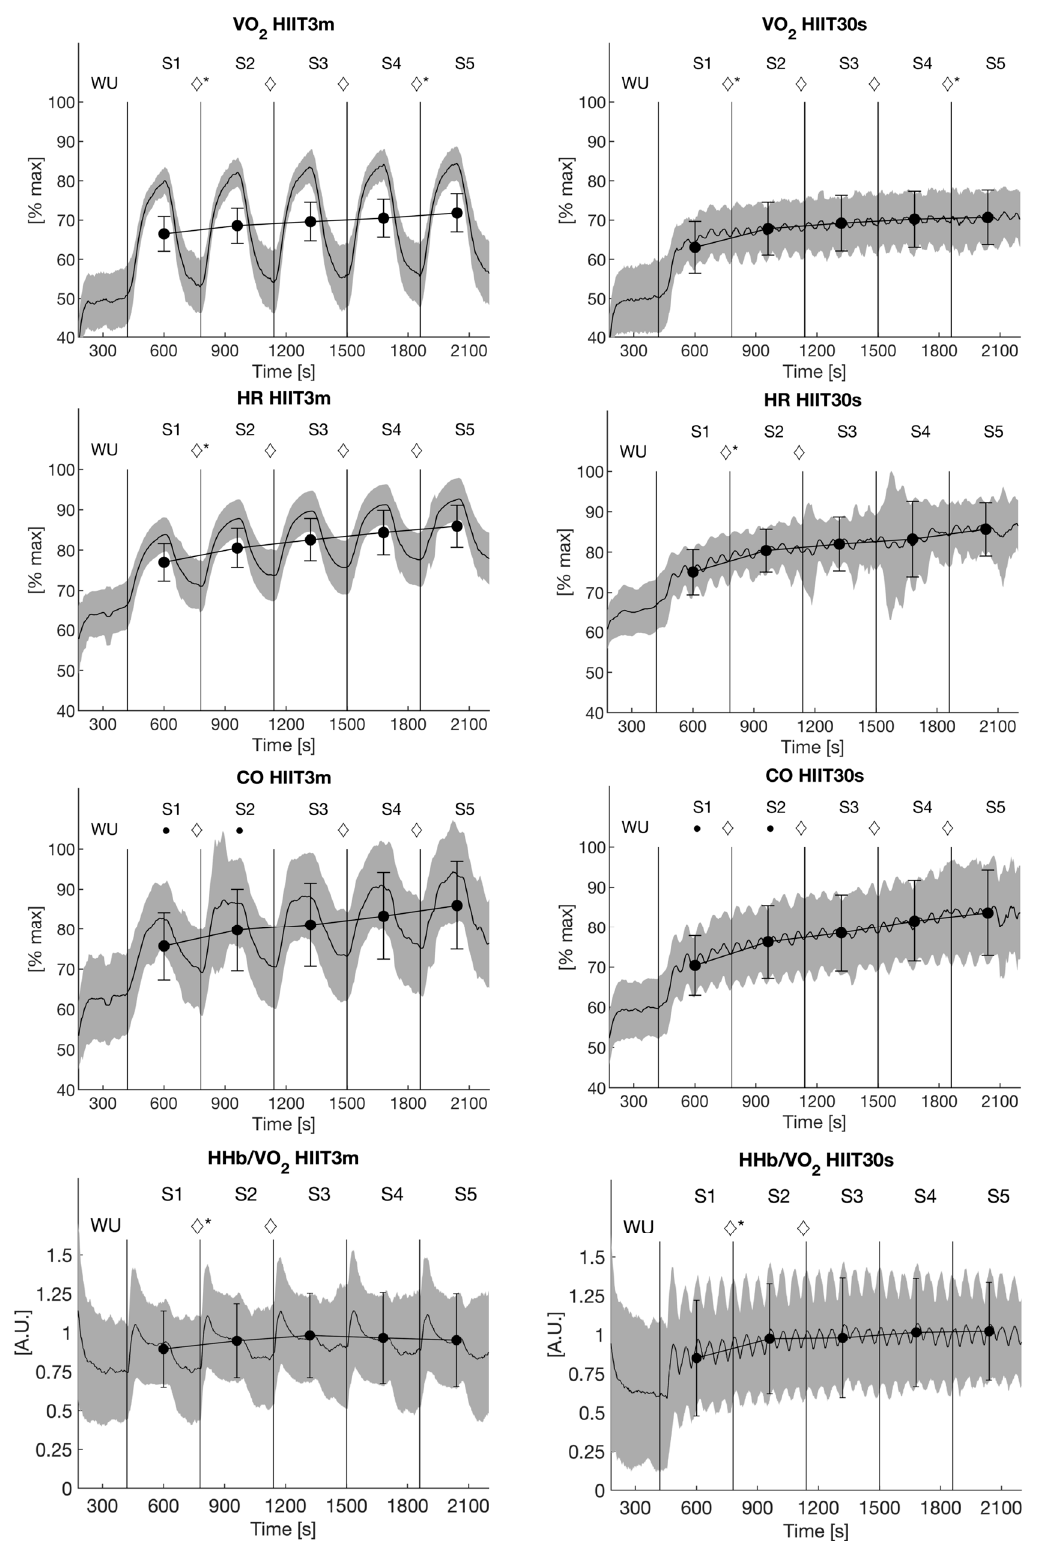
Figure 2. Averaged traces of relative oxygen uptake, heart rate, cardiac output and ∆ HHb/VO 2 ± SD (gray area); averaged values of each 6 min-section are presented as mean ± SD; ♦ indicate significant differences between two successive sections; interaction effects are marked with * ( p ≤